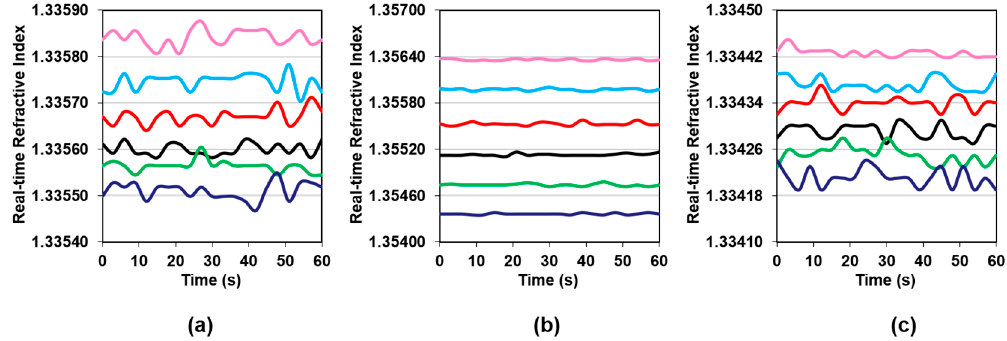
Figure 3. Inline refractive index vs. time for varying amounts of UPW added for ( a ) Fujimi PL-7106; ( b ) Klebosol 1501-50; and ( c ) CMC W7801. In all cases, Sample No. 1 is at the top, and No. 6 is at the bottom.